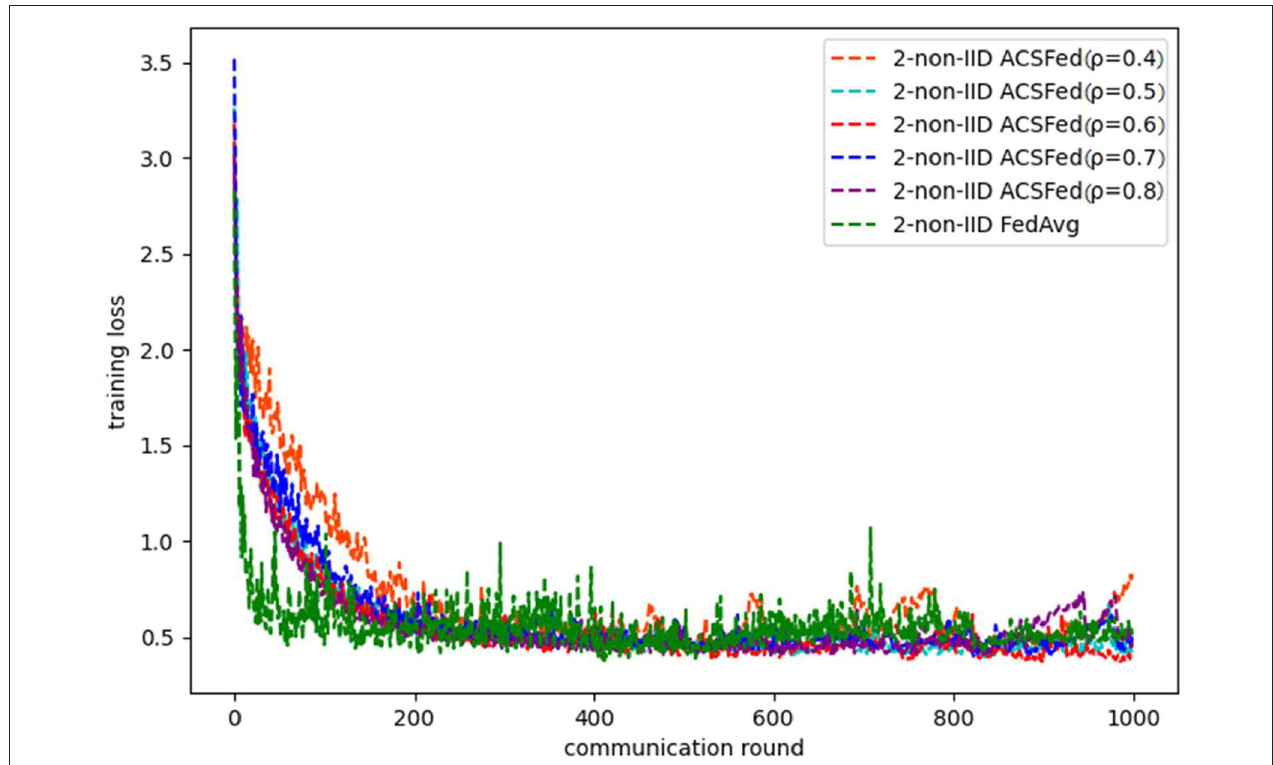
FIGURE 5 | Training loss on fashion MNIST in 2-class non-IID scenario.